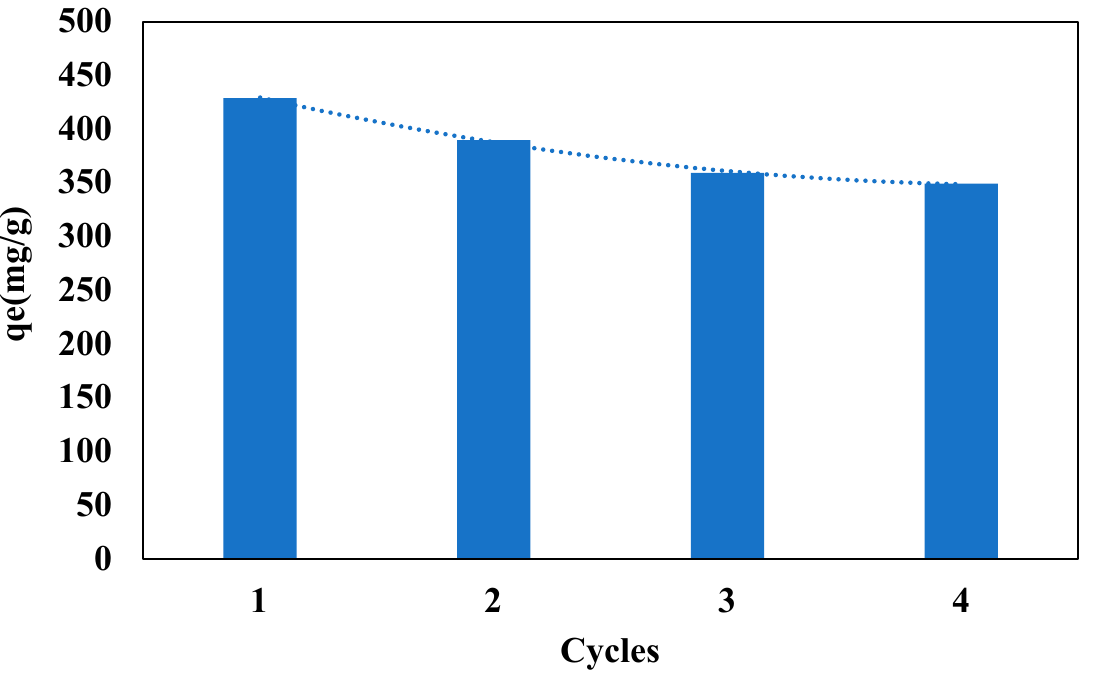
Figure 8. Regeneration study of the clay-alginate-ILs beads. 3.9. Adsorption Kinetics for the Adsorption of Oil onto the Clay-Alginate-ILs Beads’ Surface Two kinetic models, a pseudo-first order and a pseudo-second order, were applied to the experimental data to investigate the kinetics of the oil adsorption onto the Na- alginate beads. Equations (3) and (4) were used to determine the kinetics parameters for the pseudo-first-order and the pseudo-second-order, respectively [53]. The rate constants of the pseudo-first order and pseudo-second orders are k 1 (min − 1 ) and k 2 (g mg − 1 min − 1 ), respectively.